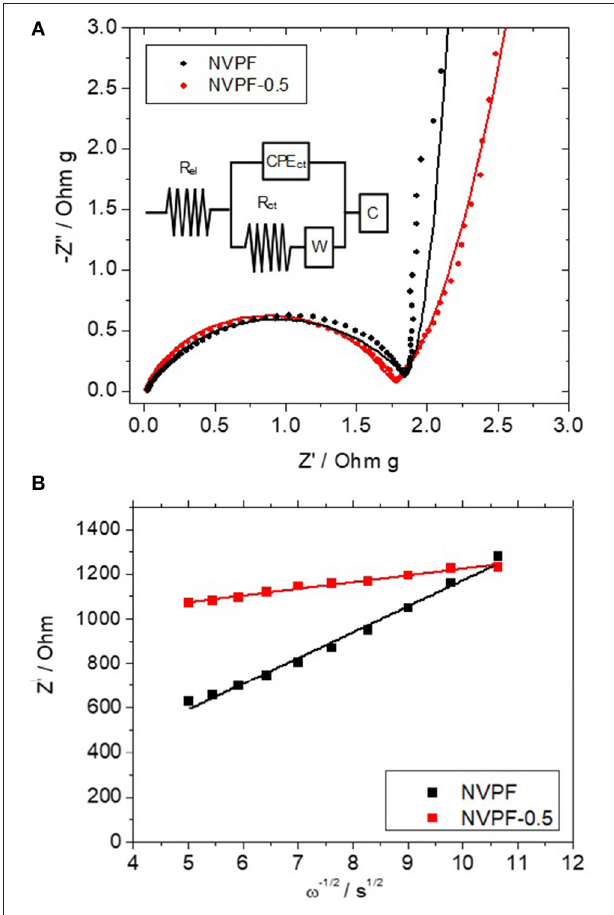
FIGURE 10 | Impedance spectra plotted as (A) Nyquist plots of NVPF and NVPF-0.5 samples. Overlapping lines correspond to the fitted spectra according to the equivalent circuit included as inset; (B) Plot of the real impedance vs. the reciprocal root square of the